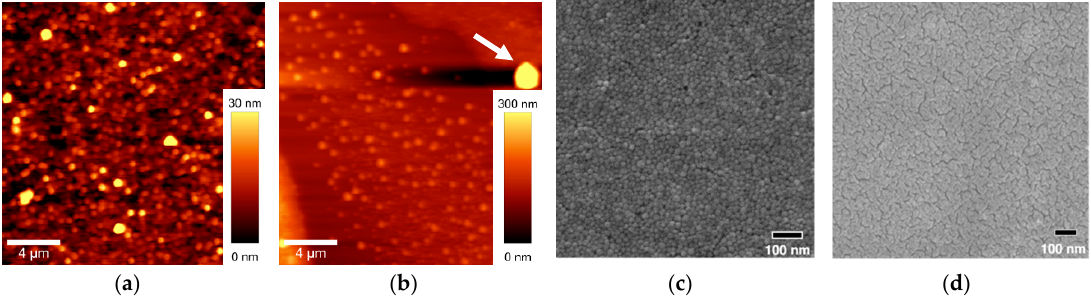
Figure 1. Atomic force microscopy (AFM) ( a , b ) and scanning electron microscopy (SEM) ( c , d ) images of the TiZr coating obtained with the dip-coating ( a , c ) and spray-coating method ( b , d ).